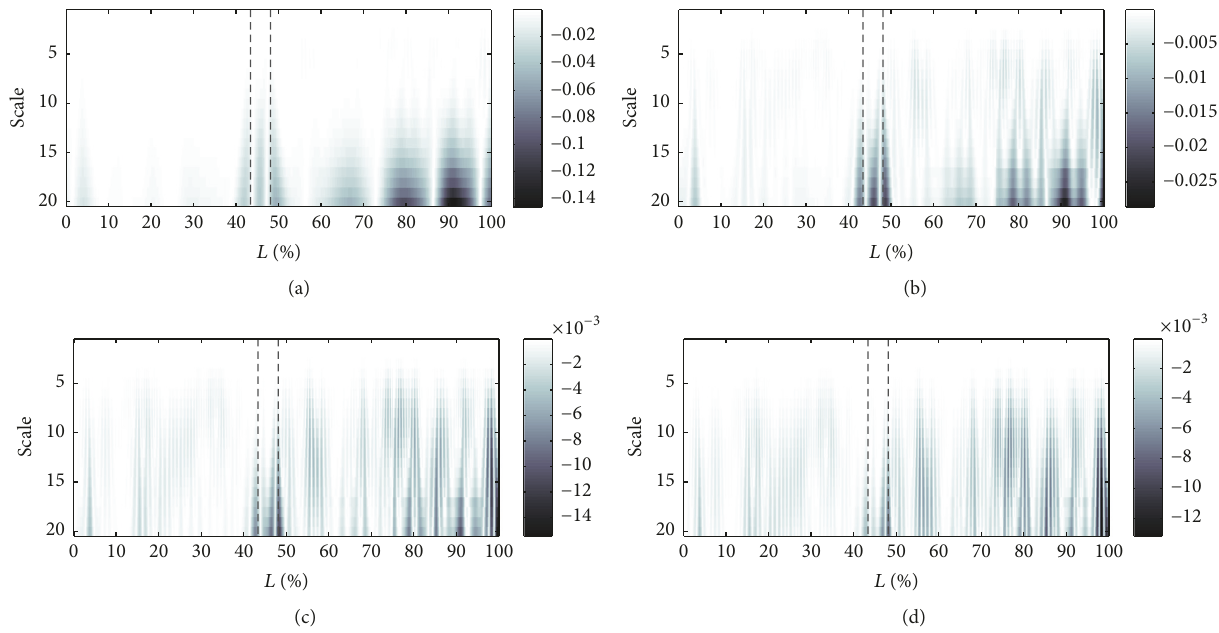
Figure 17: Scalograms of the 7th mode of natural vibrations in the case of different numbers of interpolation points: (a) 2; (b) 4; (c) 6; (d) 8.